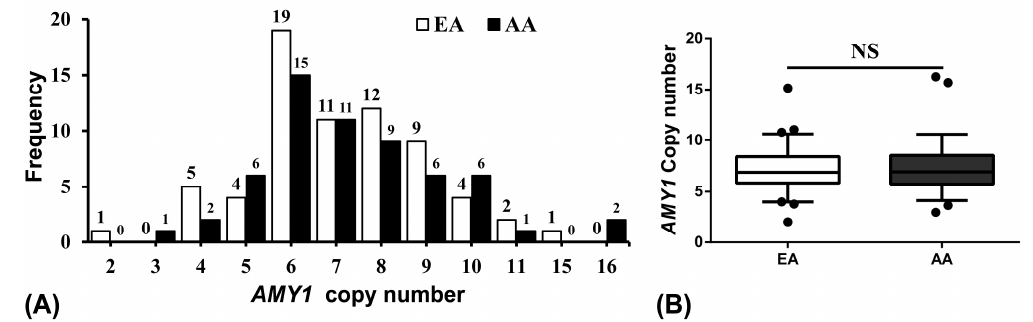
Figure 2. The AMY1 copy number in White/European American (EA) and African American (AA) children. ( A ) Distribution of AMY1 copy number in European American and African American children. The copy number of AMY1 was rounded to nearest integer. ( B ) Mean AMY1 copy number in European American and African American. NS—No significance.